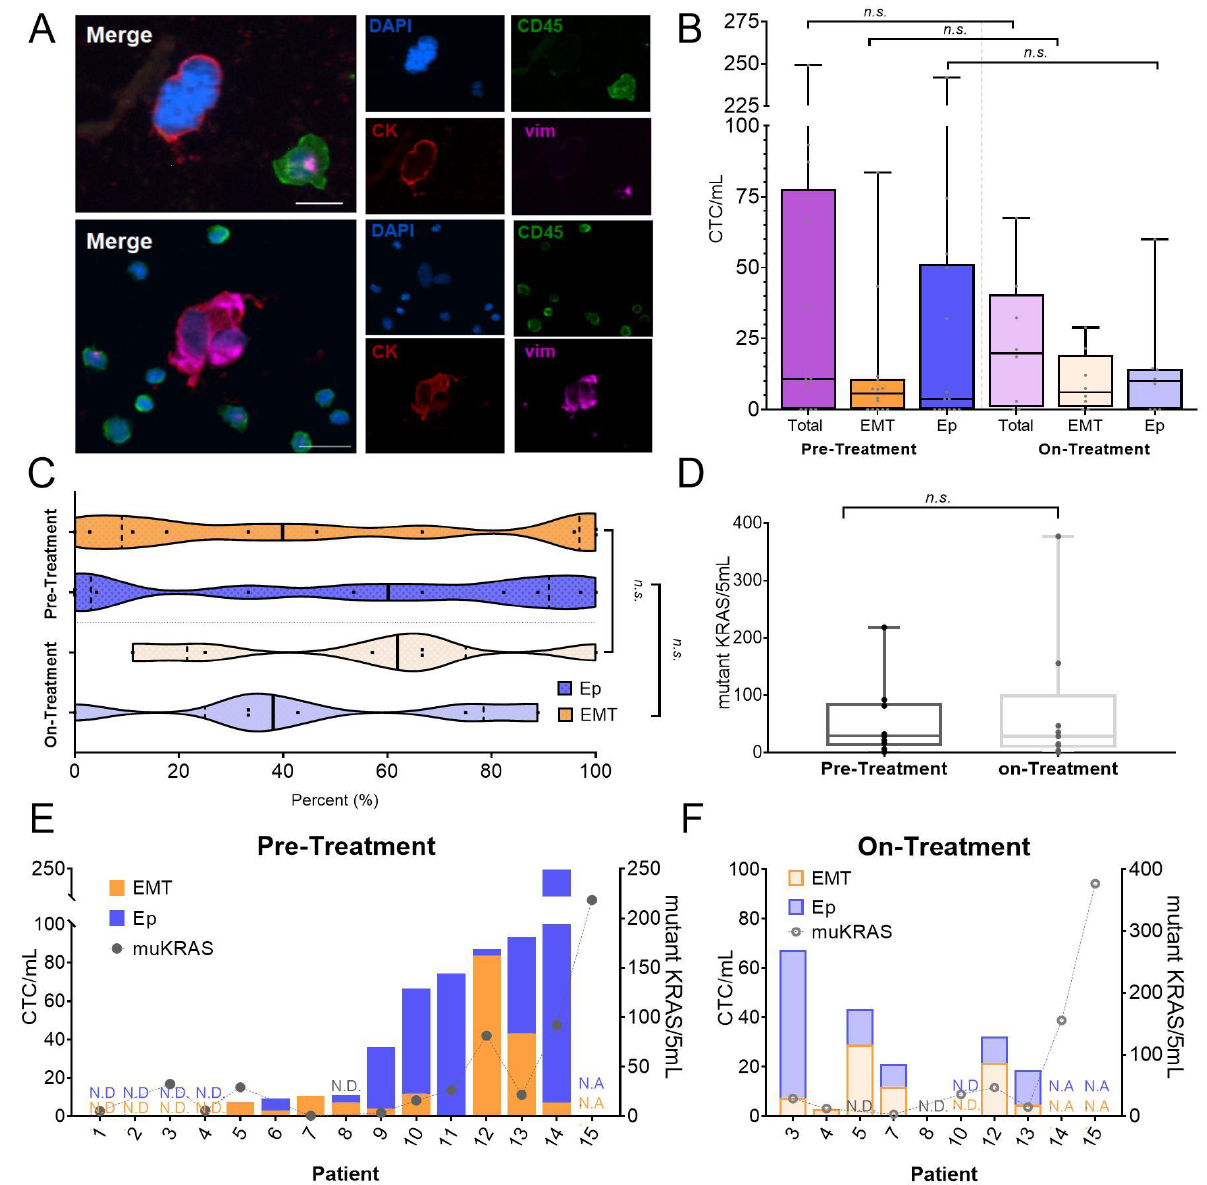
Figure 2. CTC enumeration, phenotype and mutant KRAS burden profiling. ( A ) Image of an Ep CTC (top panel) and two EMT CTCs (bottom panel) surrounded by white blood cells. Scale bar represents 20 µ m. ( B ) CTC enumeration based on phenotype for pre-treatment and on-treatment samples. ( C ) Distribution of CTC phenotype based on time point. ( D ) Mutant KRAS expression assessed by ddPCR in CTCs based on time point. ( E , F ) Comparison of CTC counts based on phenotype with mutant KRAS (muKRAS) expression for ( E ) pre-treatment and ( F ) on-treatment CTC samples. N.A. = not available. N.D. = not detected. n.s. = not